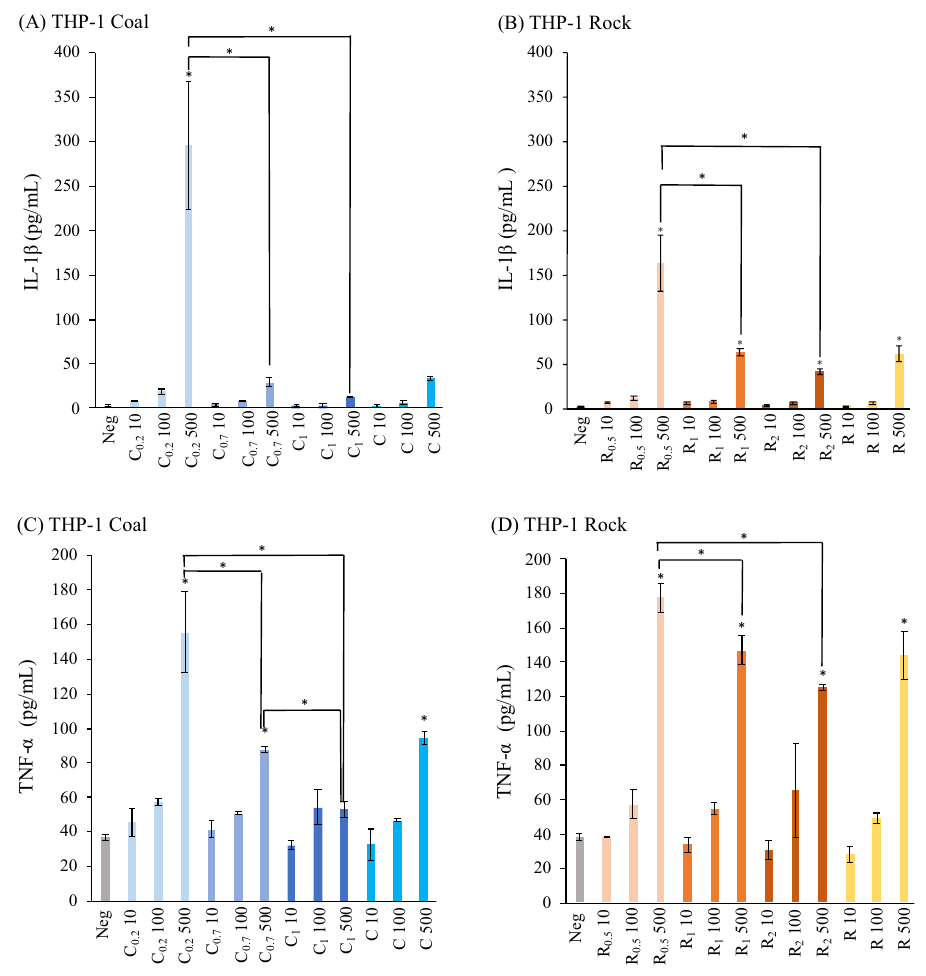
Figure 6. Inflammatory cytokines expressions for THP-1 cells of various coal and rock dust treatment (10, 100, 500 µg/ml): ( A , B ) IL-1β; ( C , D ) TNF-α * over an individual bar indicates p < 0.05 between the individual treatment and negative control. * over a joining bar indicates p < 0.05 between the two joined